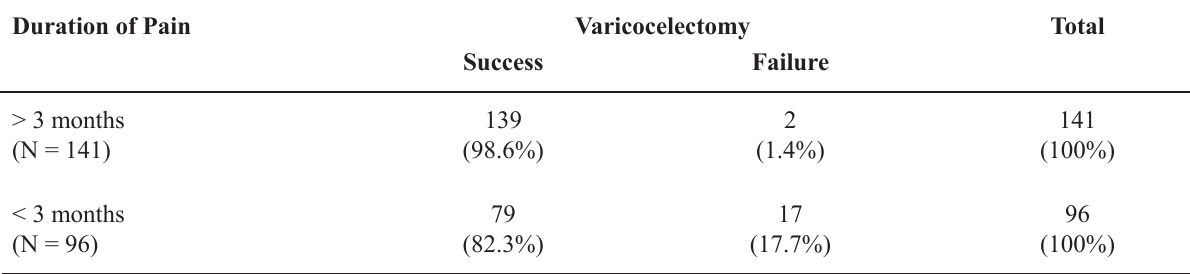
Table 1 – Results of varicocelectomy according to duration of pain. Duration of